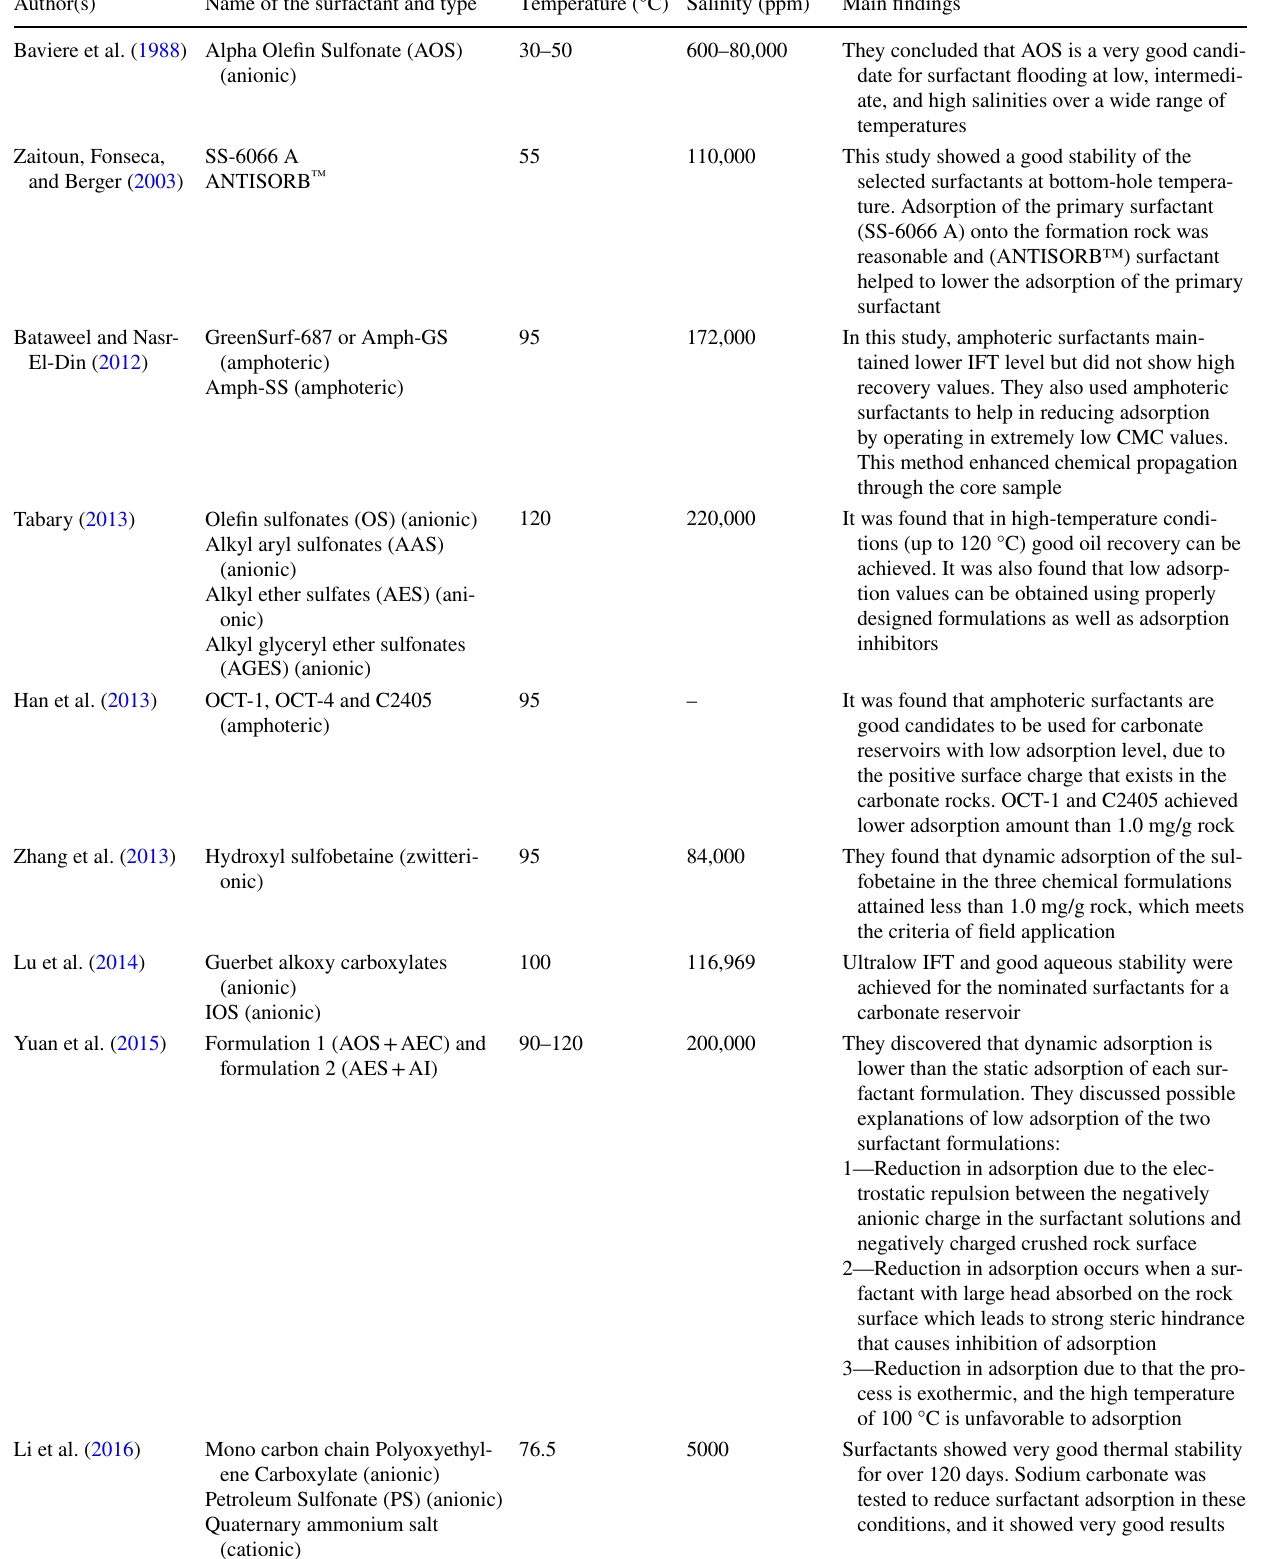
Table 2 Summary of several studies highlighting the effect of temperature on surfactant adsorption